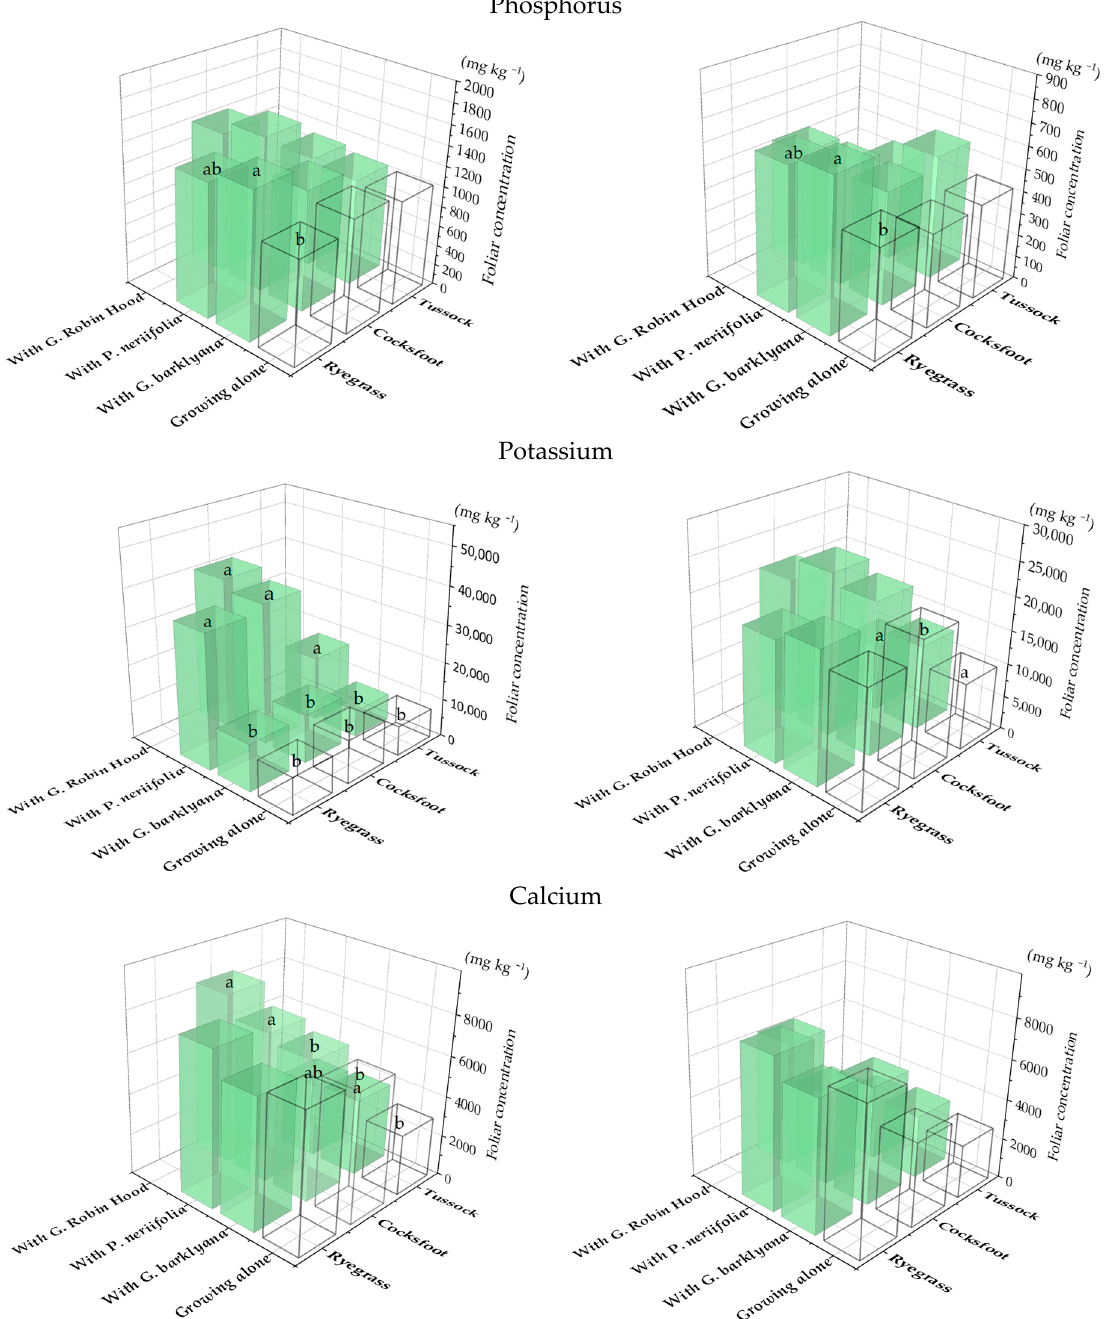
Figure 4. Phosphorus, Ca, and Mn concentrations in the foliage of the three species of grass ( Lolium perenne , ryegrass; Dactylis glomerata , cocksfoot; Poa cita , tussock grass) when they were growing alone (open bars) or with one of three species of proteas (coloured bars). Charts show 1st (LHS) and 2nd (RHS) sampling. Different letters each indicate significant differences ( p < 0.05) each for each species of grass (full data in Appendix A, Table A2).